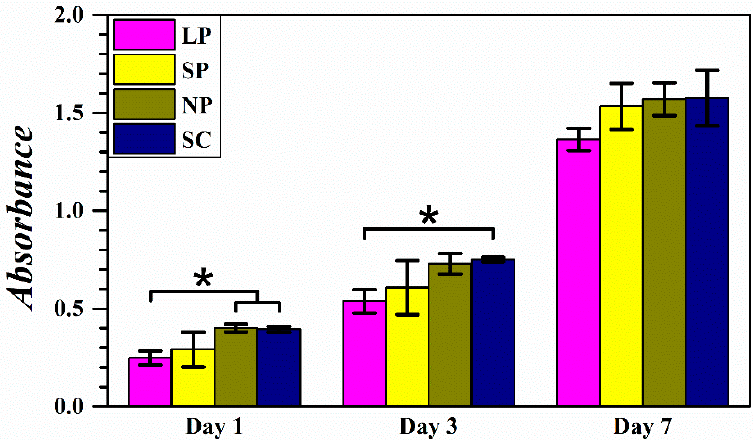
Figure 5. Absorbance in WST tests after 1, 3, and 7 days of cell proliferation on LP, SP, NP, and SC membranes ( n = 3; * p < 0.05).